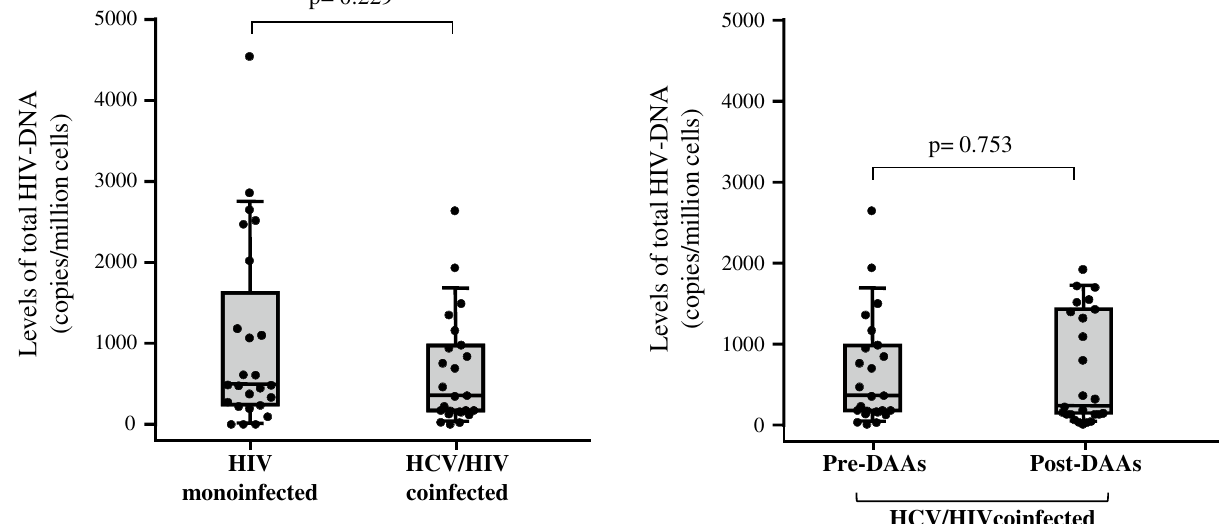
Figure 1. Levels of total HIV-DNA content in purified CD4 + T cells. Whisker Box-plots showing the levels of total HIV-DNA content in purified CD4 + T cells from HIV-monoinfected and in HCV/HIV-coinfected patients (left graph); and levels of total HIV-DNA content in CD4 + T cells from HCV/HIV-coinfected patients before and after HCV eradication with DAAs-based treatment (right graph). p-values for inter and intra-group comparisons (Mann–Whitney U test and Wilcoxon signed-rank test, respectively) are